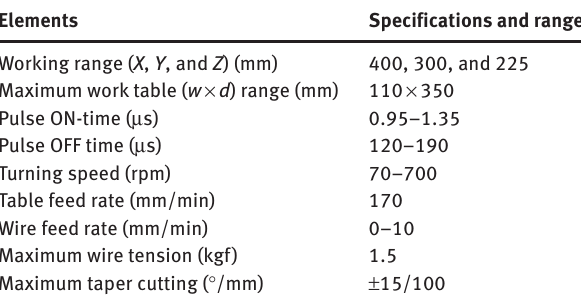
Table 2: Technical specifications of the WEDT setup.